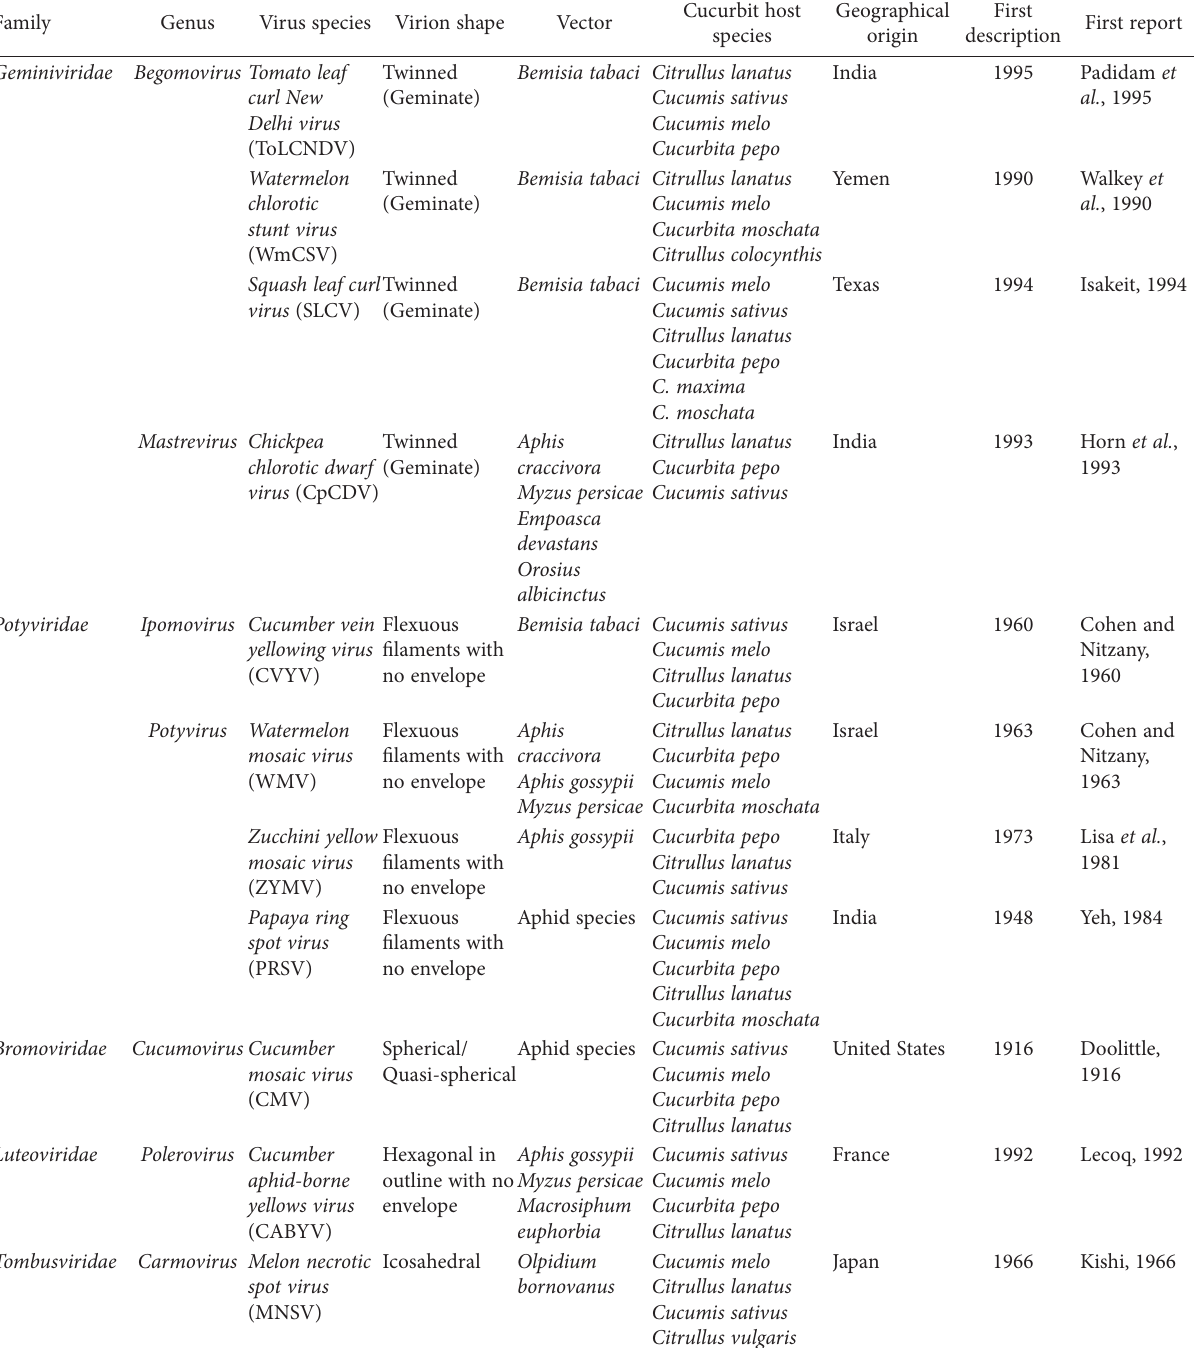
Table 1. Taxonomy, virion shape, host range, and origin of detection of viruses inducing diseases on cucurbit crops. Family